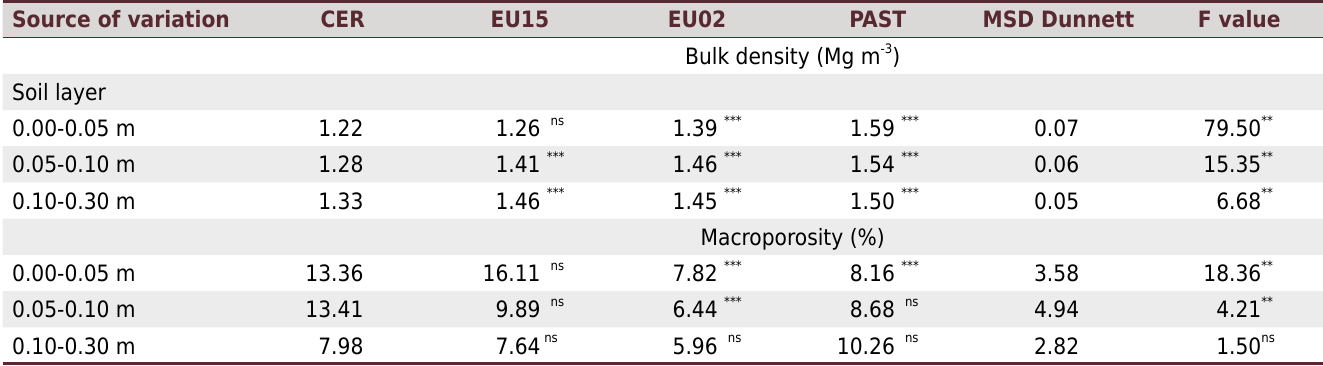
Table 3. Partitioning of the interaction between CER and each land use (preserved Cerrado - CER, 15-year-old Eucalyptus - EU15, 2 year-old Eucalyptus - EU02, and Pasture - PAST) in each soil layer for macroporosity and bulk density Source of variation